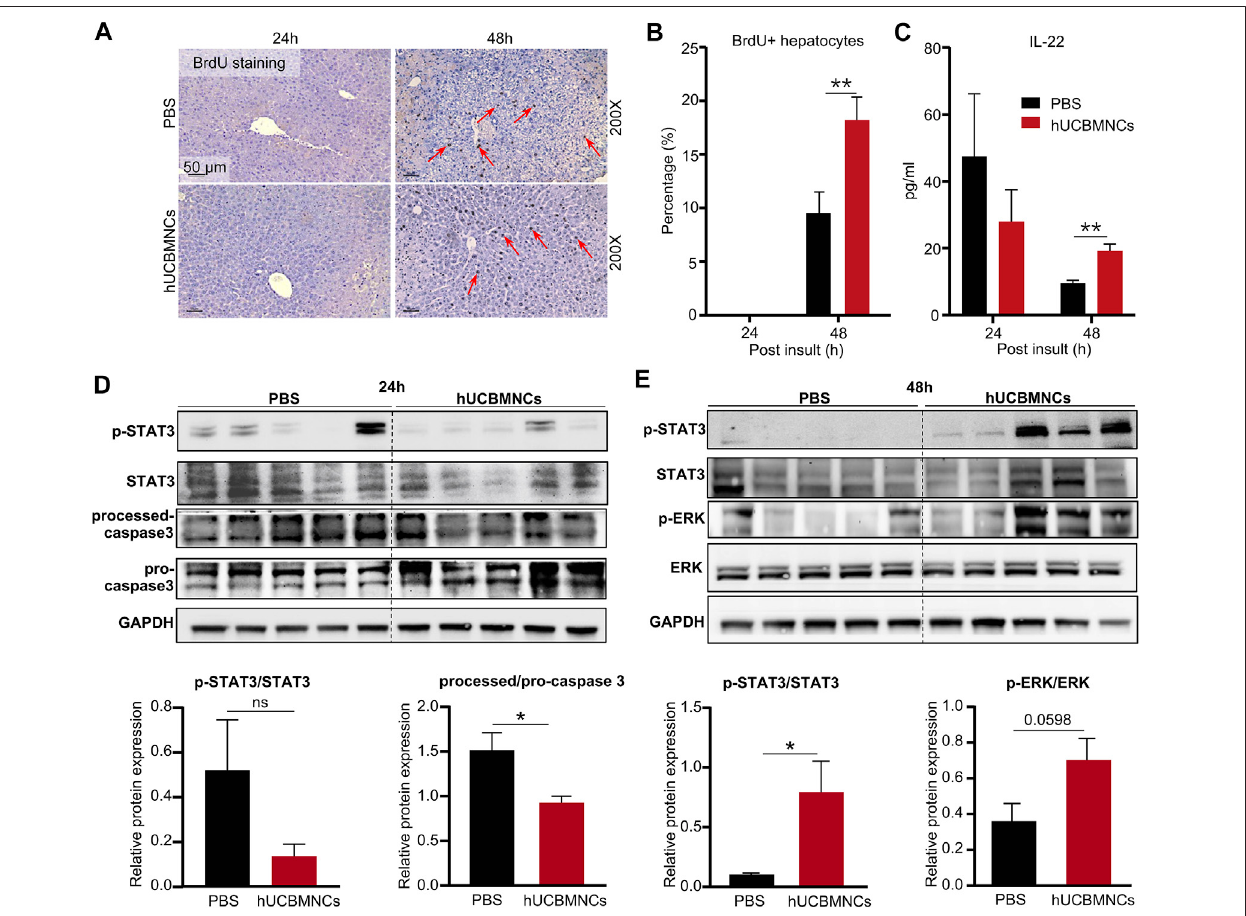
FIGURE4| hUCBMNCstreatmentpromotedliverregenerationat48hpostCCl 4 injectionviaIL-22. (A) BrdUstainingofliverslicesat24 h,48 hpostCCl 4 injection (PBS, n = 5/time point; hUCBMNCs, n = 5/time point). (B) Percentage of BrdU positive hepatocytes. (C) Serum IL-22 levels in the hUCBMNCs group ( n = 4/time point) and thecontrolgroup( n =4/time point). (D,E) Westernblottingresultsofproteinsand relative proteinexpression inliverregenerationandapoptosis pathways, including p-STAT3,STAT3,processed-caspase3,pro-caspase3,p-ERK,ERK,andGAPDHat24 h (D) and48 h (E) postCCl 4 injection( n =5/timepoint,experimentswere repeated for 3 times). The bars represent mean ±